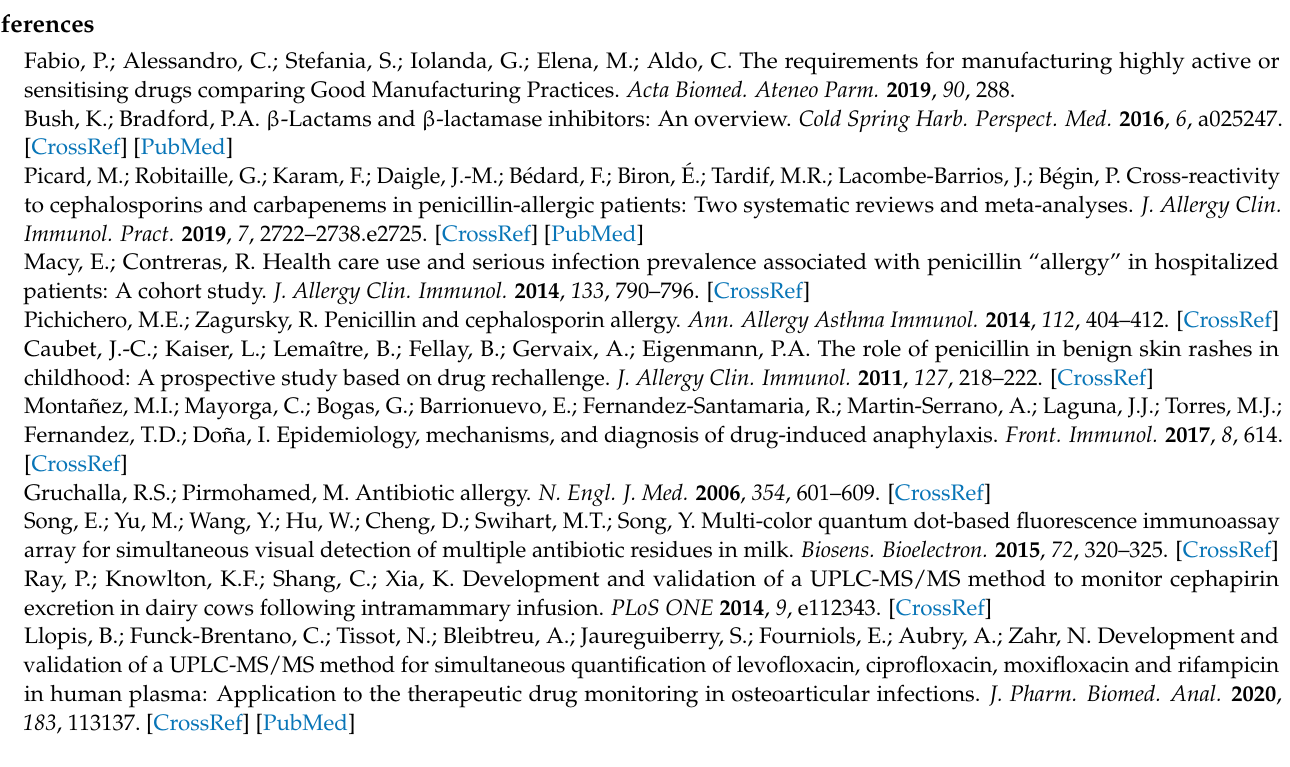
lution; Figure S4: MS/MS chromatogram of Cephapirin LOQ solution; Figure S5: MS/MS chro- matograms of Cephapirin LOQ Precision; Figure S6: MS/MS chromatogram of Ceftiofur LOD solution; Figure S7: MS/MS chromatogram of Ceftiofur LOQ Precision; Figure S8: MS/MS chro- matogram of Ceftiofur Linearity; Figure S9: MS/MS chromatograms of Cephapirin Method pre- cision; Figure S10: MS/MS chromatograms of Ceftiofur Method precision; Figure S11: MS/MS chromatograms of Cephapirin Intermediate precision; Figure S12: MS/MS chromatograms of Ceftiofur Intermediate precision; Figure S13: MS/MS chromatograms of Cephapirin Accuracy; Figure S14: MS/MS chromatograms of Ceftiofur